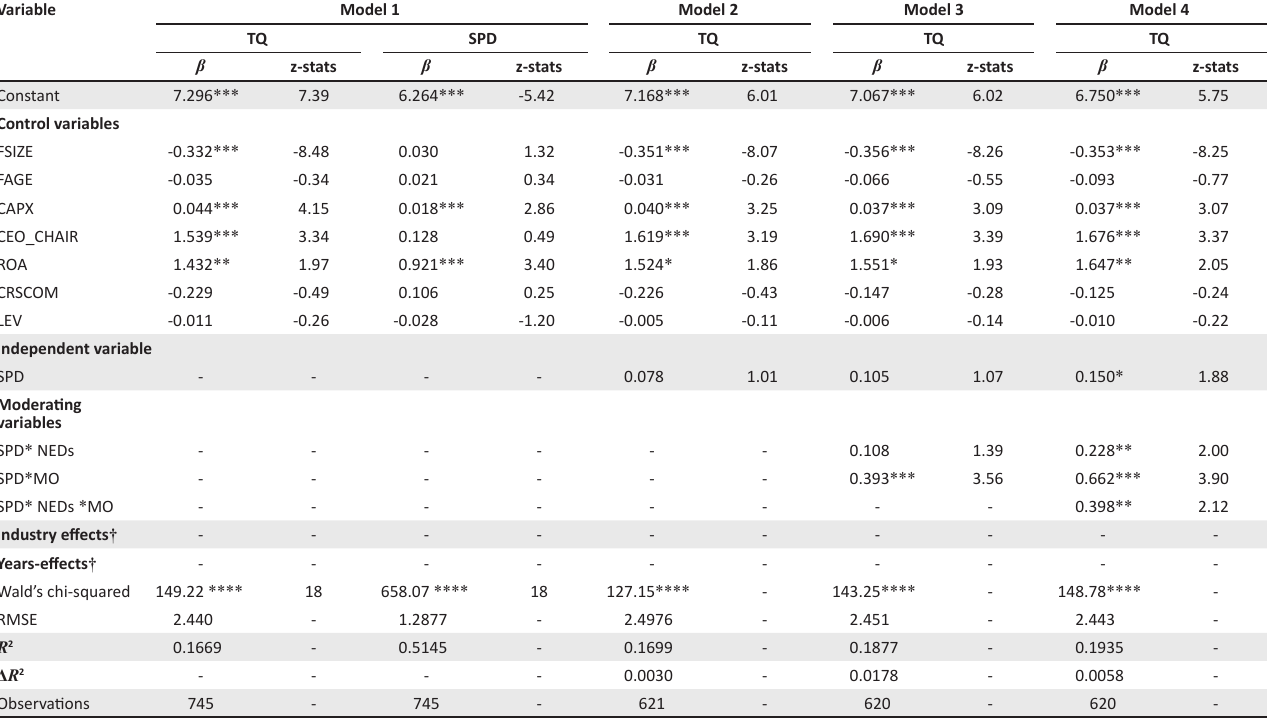
TABLE 4: Seemingly unrelated regression results examining the moderating role of board independence and managerial ownership on voluntary social performance disclosure and firm profitability nexus.